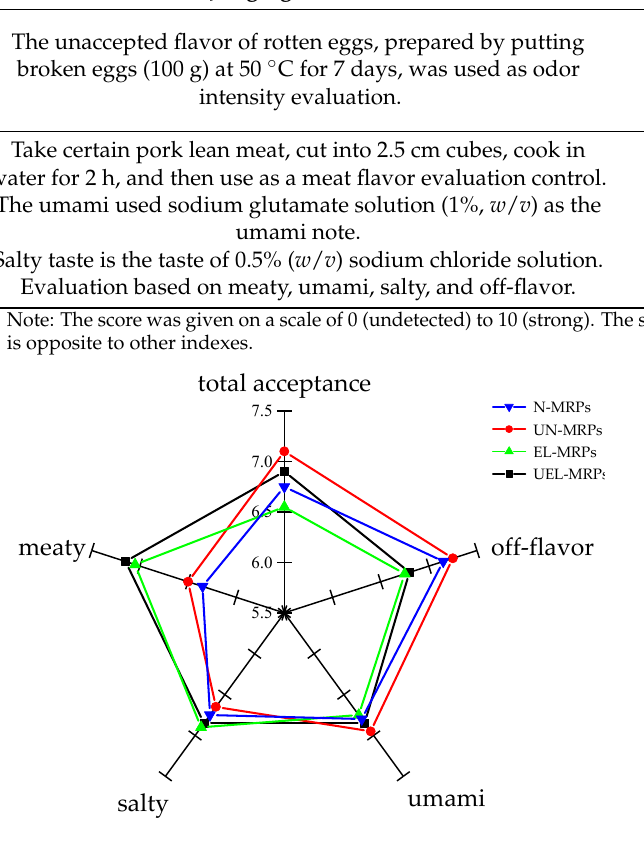
Figure 3. Sensory characteristics of various MRPs.